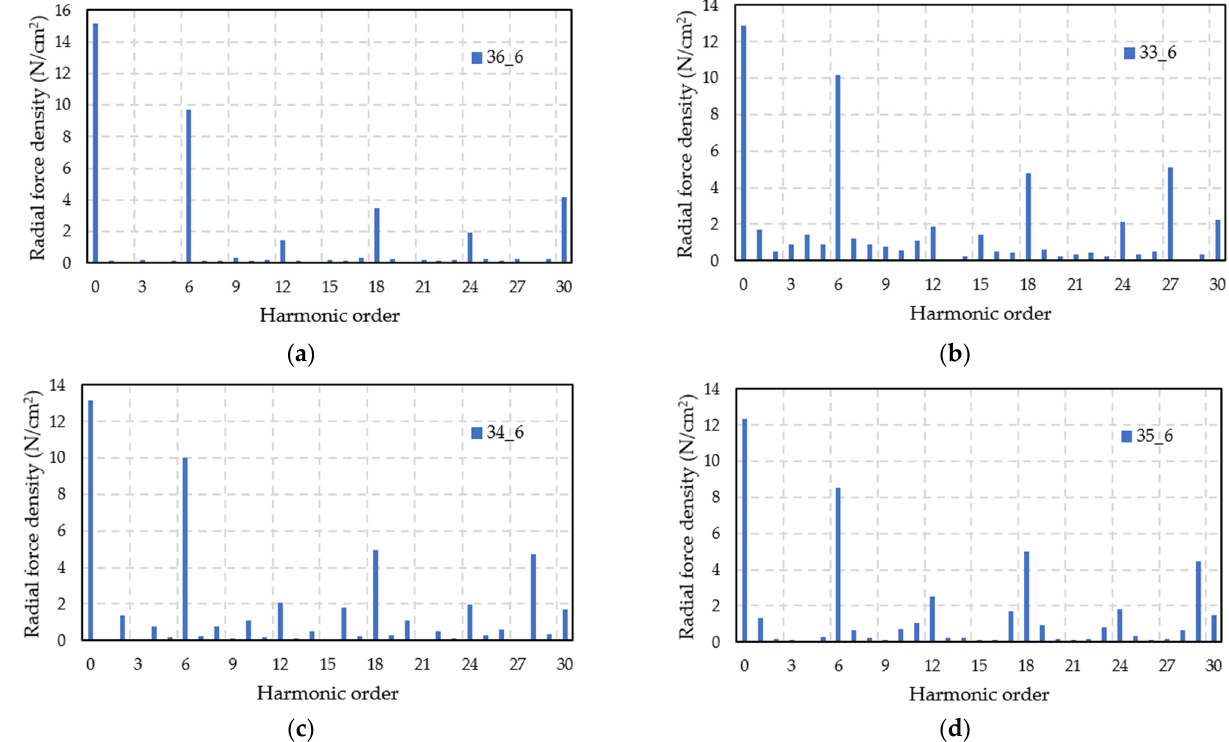
Figure 11. Radial force density harmonics of four motors without flux barrier: ( a ) M 1 : 36 − slot and 6 − pole; ( b ) M 2 : 33 − slot and 6 − pole; ( c ) M 3 : 34 − slot and 6 − pole; ( d ) M 4 : 35 − slot and 6 − pole.